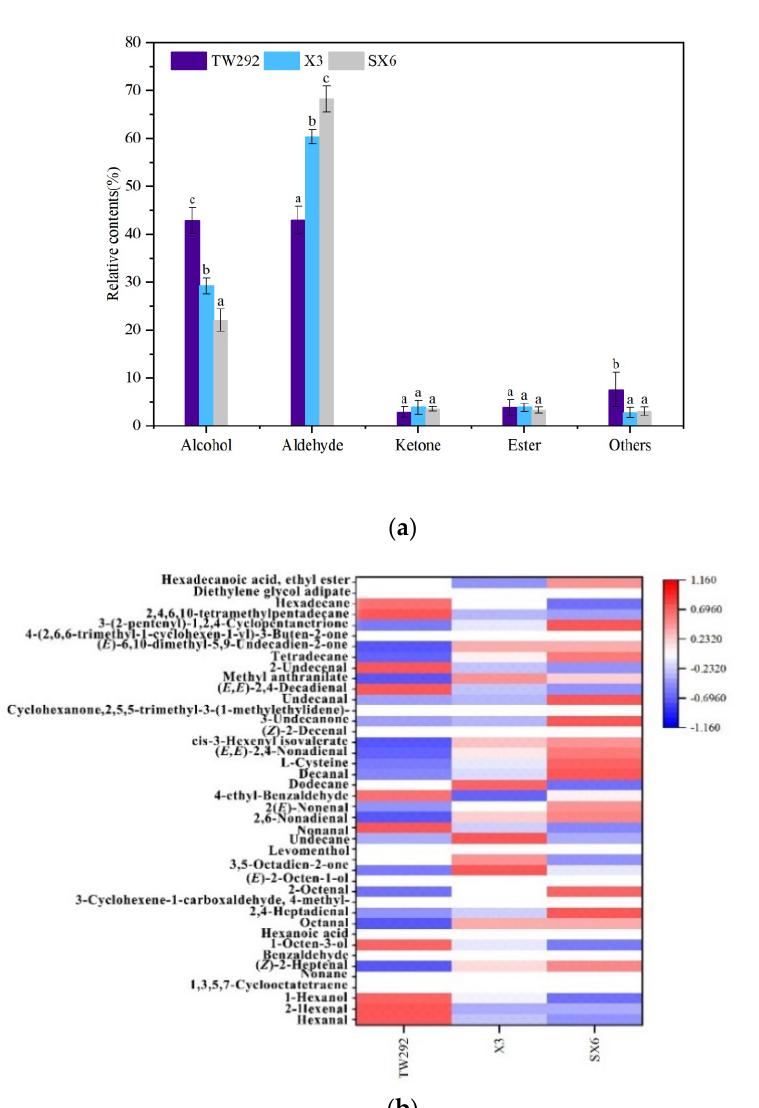
Figure 5. ( a ) Relative content of volatile compounds among different classes in three vegetable soybean samples. Significant difference ( p < 0.05) is represented by a, b, and c; ( b ) Heat map of the selected major volatile compounds in three vegetable soybeans.